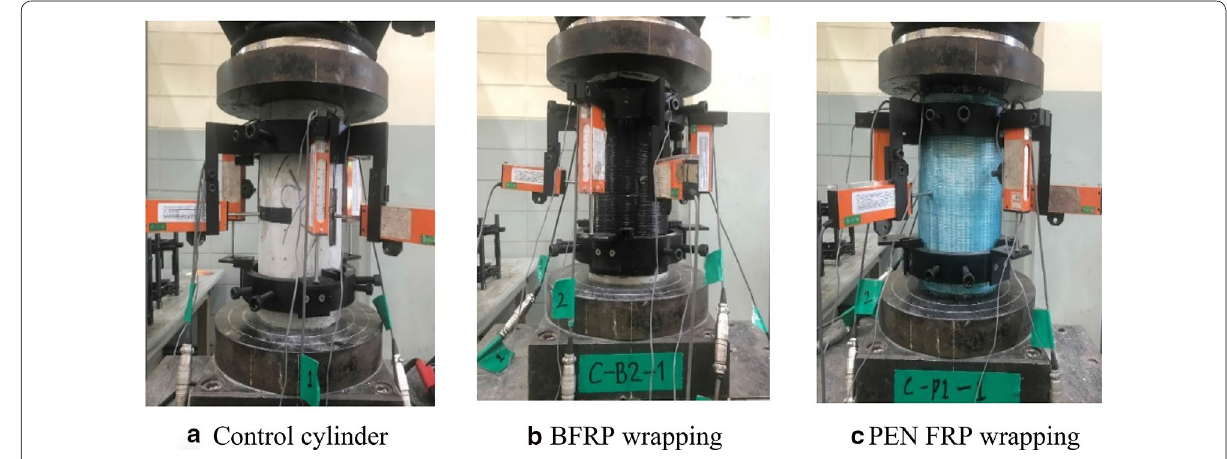
Fig. 5 Compression test under progress.